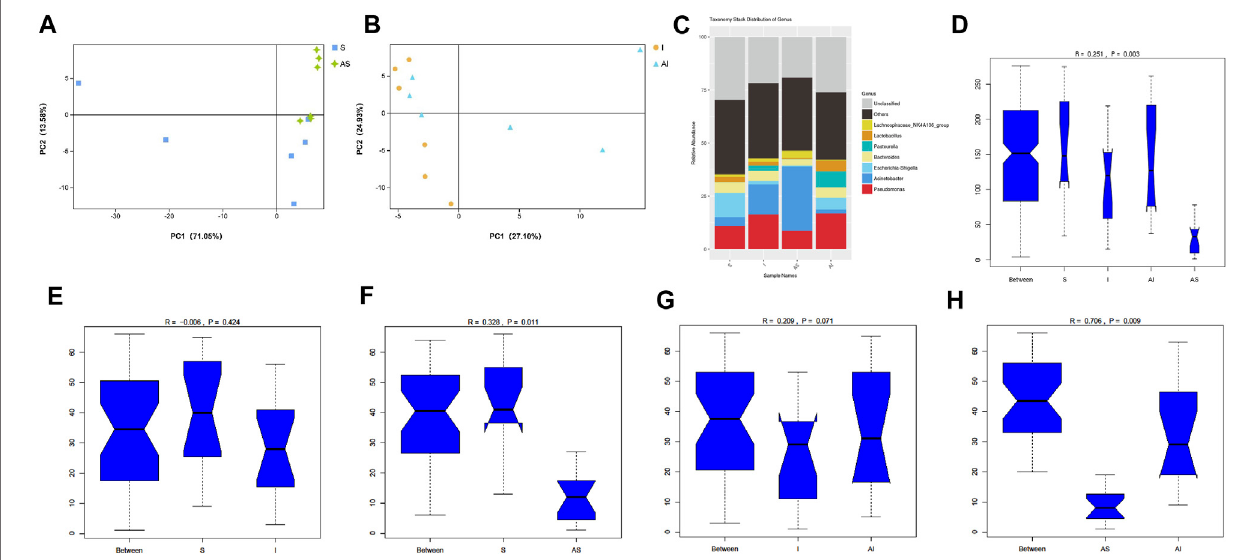
FIGURE 3 | The composition and variance of the microbial communities in all four groups. PCA of bacterial patterns in the lung microbiota community between group S and AS (A) , and between group I and group AI (B) . The lung microbial community structures of the four groups (C) . Boxplots based on the Unweighted Unifrac index were used to show the differences in the mean value of ranks between groups visually (D – H) . The analysis was tested using analysis of similarities (Anosim) PCA: principal component analysis; S: Sham; AS: ARB + Sham; I: injury; AI: ARB +